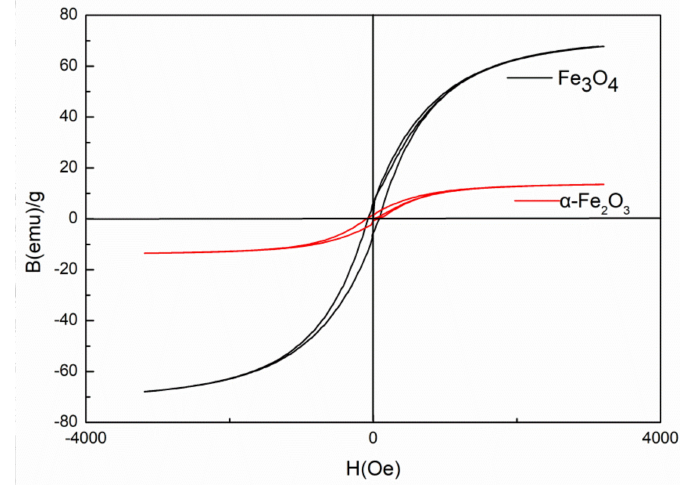
Figure 2. Magnetic hysteresis loops of Fe 3 O 4 and α -Fe 2 O 3